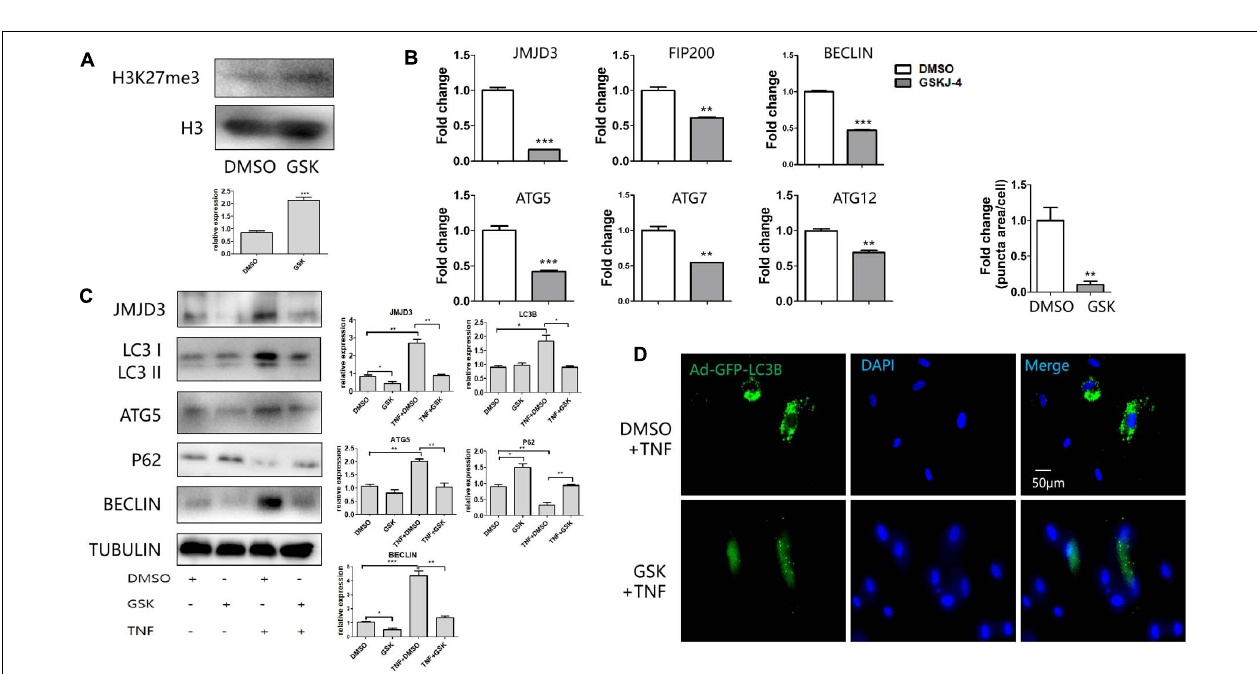
Frontiers in Cell and Developmental Biology |